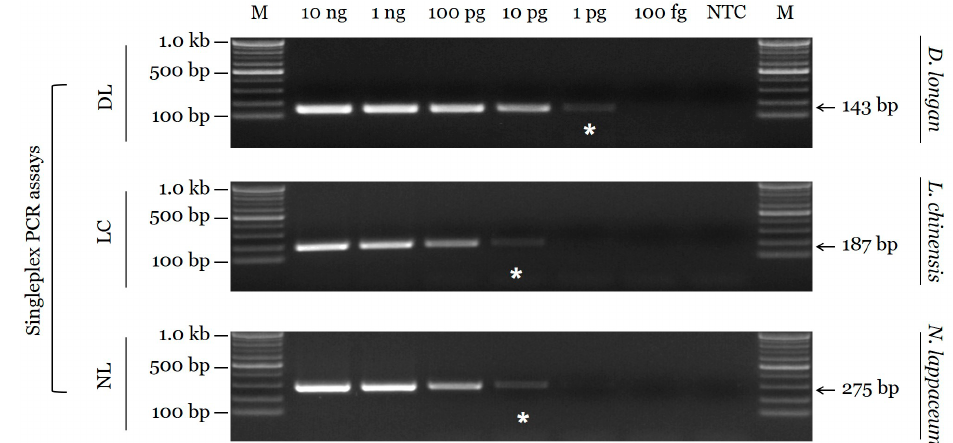
Figure 3. Sensitivity of singleplex PCR assays using the species-specific primer sets. M: 100 bp DNA size marker (100–1000 bp), NTC: no template control. Arrowheads indicate the amplified fragment sizes. White asterisks indicate the limit of detection.